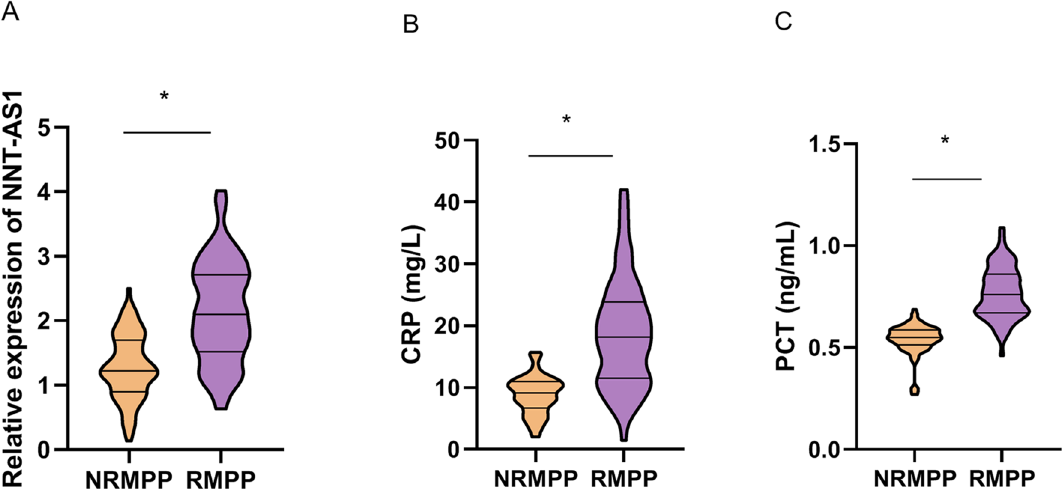
Figure 1. Serum expressions of LncRNA NNT-AS1, CRP and PCT between NRMPP and RMPP. (A) Detection by qRT-PCR, the serum expression of LncRNA NNT-AS1 in RMPP children was significantly higher than that in NRMPP children. (B) Blood test results showed that compared with NRMPP children, serum expression of CRP was significantly increased in RMPP children. (C) Blood test results showed that compared with NRMPP children, serum expression of PCT was significantly increased in RMPP children.